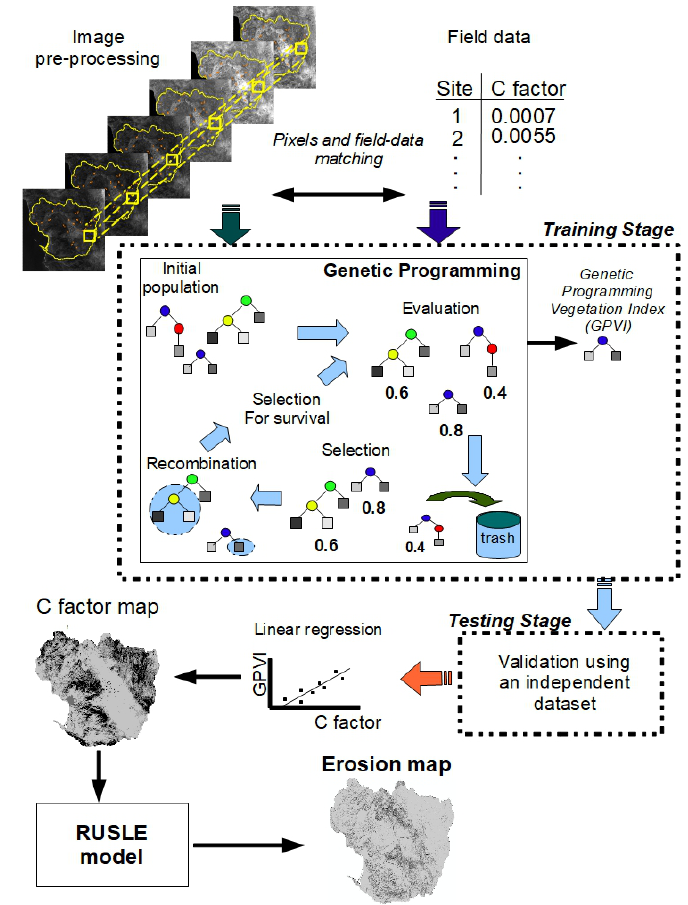
Figure 3. Flowchart of the methodology used to define the C factor from the VIs generated by the Genetic Programming (GP)